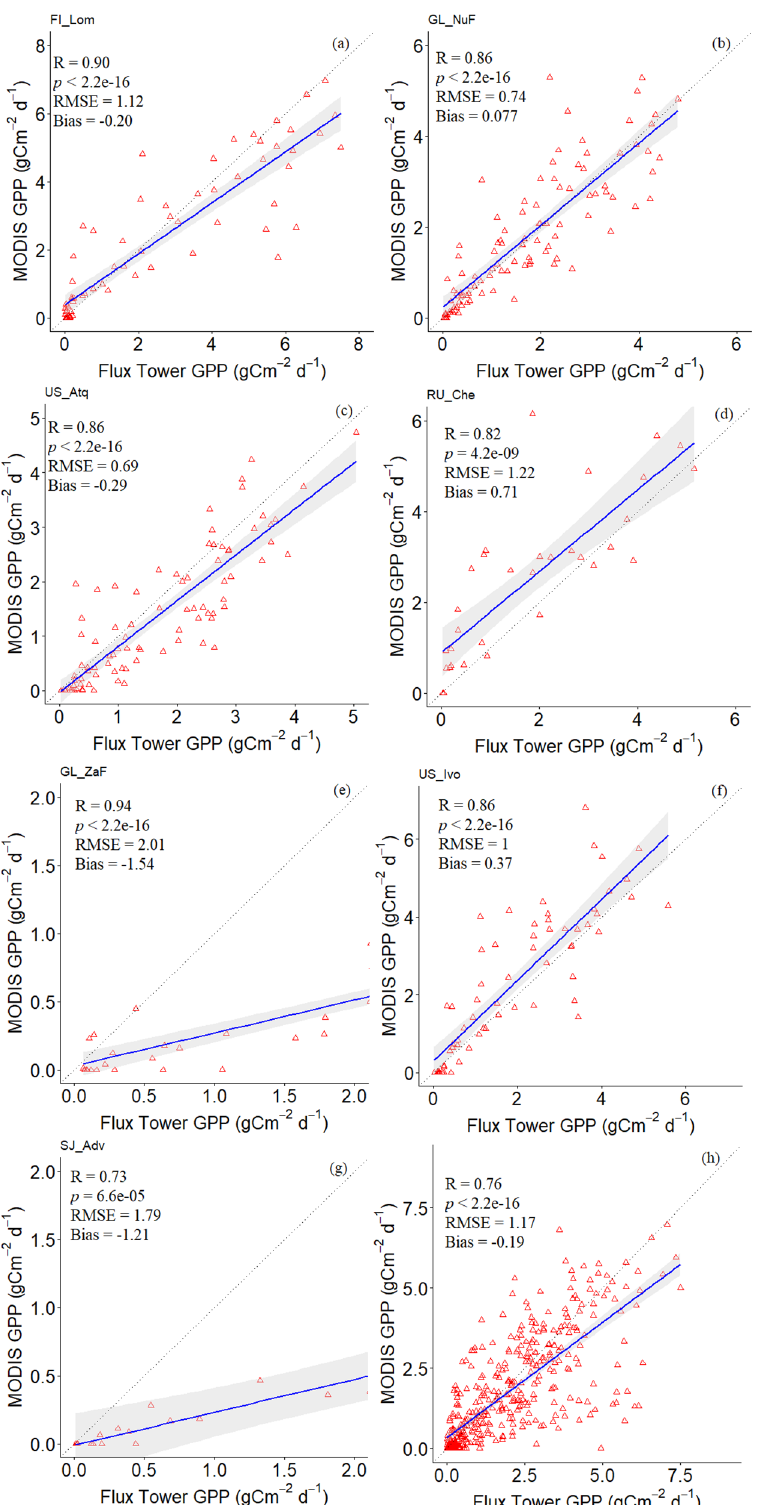
Figure 3. Scatter plots of site-based GPP against MOD17A2H over different wetland sites ( a – g ) and the overall scatter plots by combining all wetland sites ( h ). Flux tower GPP means in situ GPP . The gray belt refers to the confidence interval of 95%.